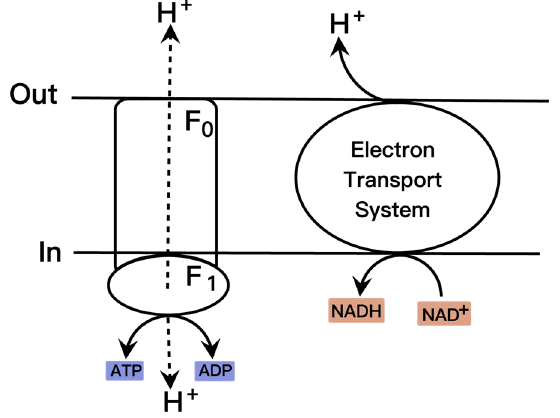
Figure 2. Oxidative phosphorylation of NADH in microorganisms.